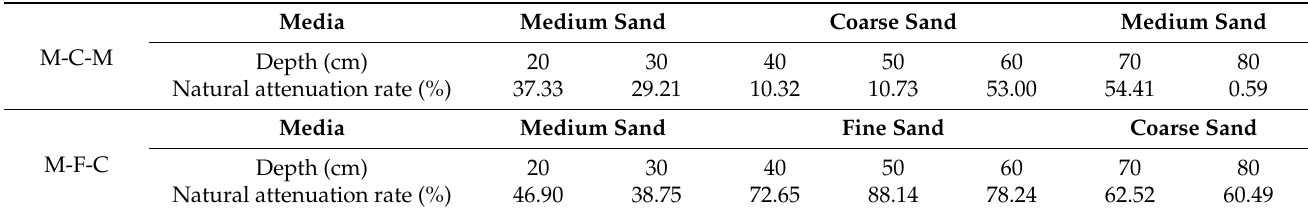
Table 5. Natural attenuation rate of diesel in different soil